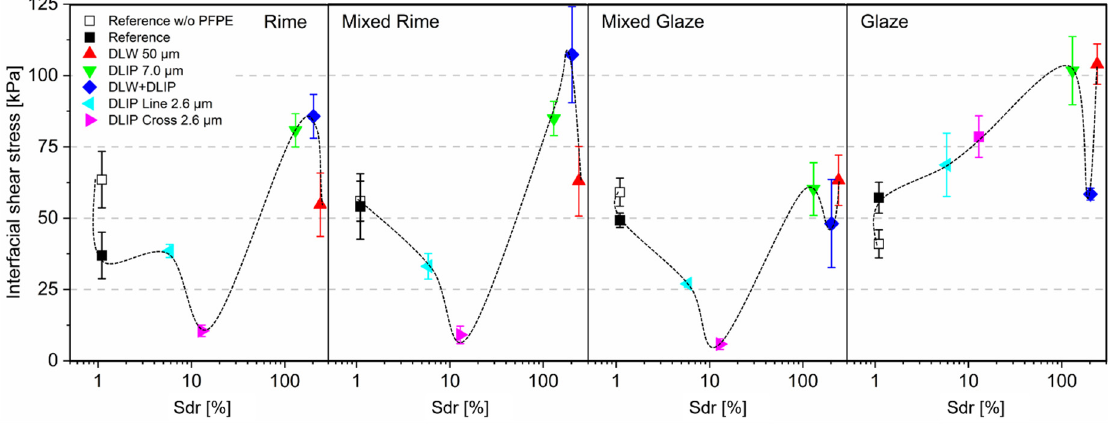
Figure 6. Interfacial shear stress of the laser-treated samples and the two references as a logarithmic function of the Sdr ratio for the icing conditions of rime, mixed rime, mixed glaze, and glaze. The black dashed spline is meant only to guide the eye of the reader.